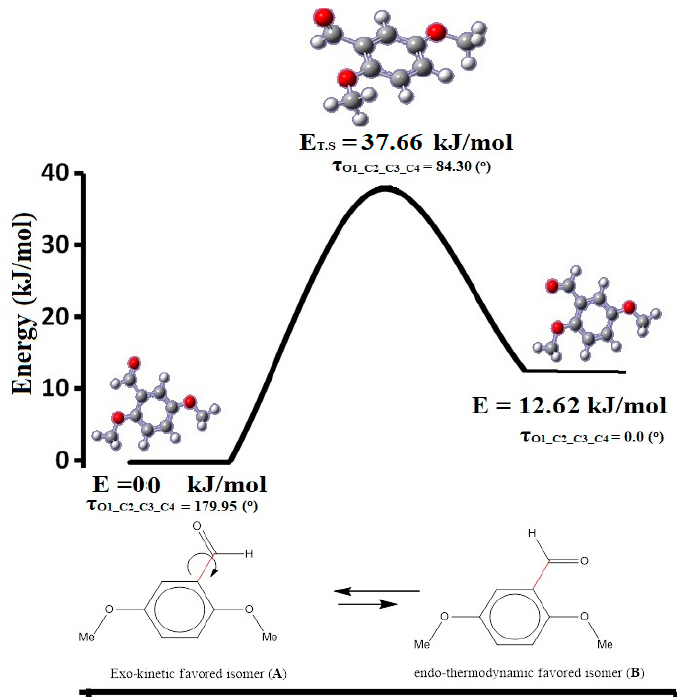
Figure 4. Energy profile and global minimum structures of the exo- and endo -2,5-dimethoxybenzaldehyde isomers and the transition state (TS) of the exo ⬄ endo isomerization.